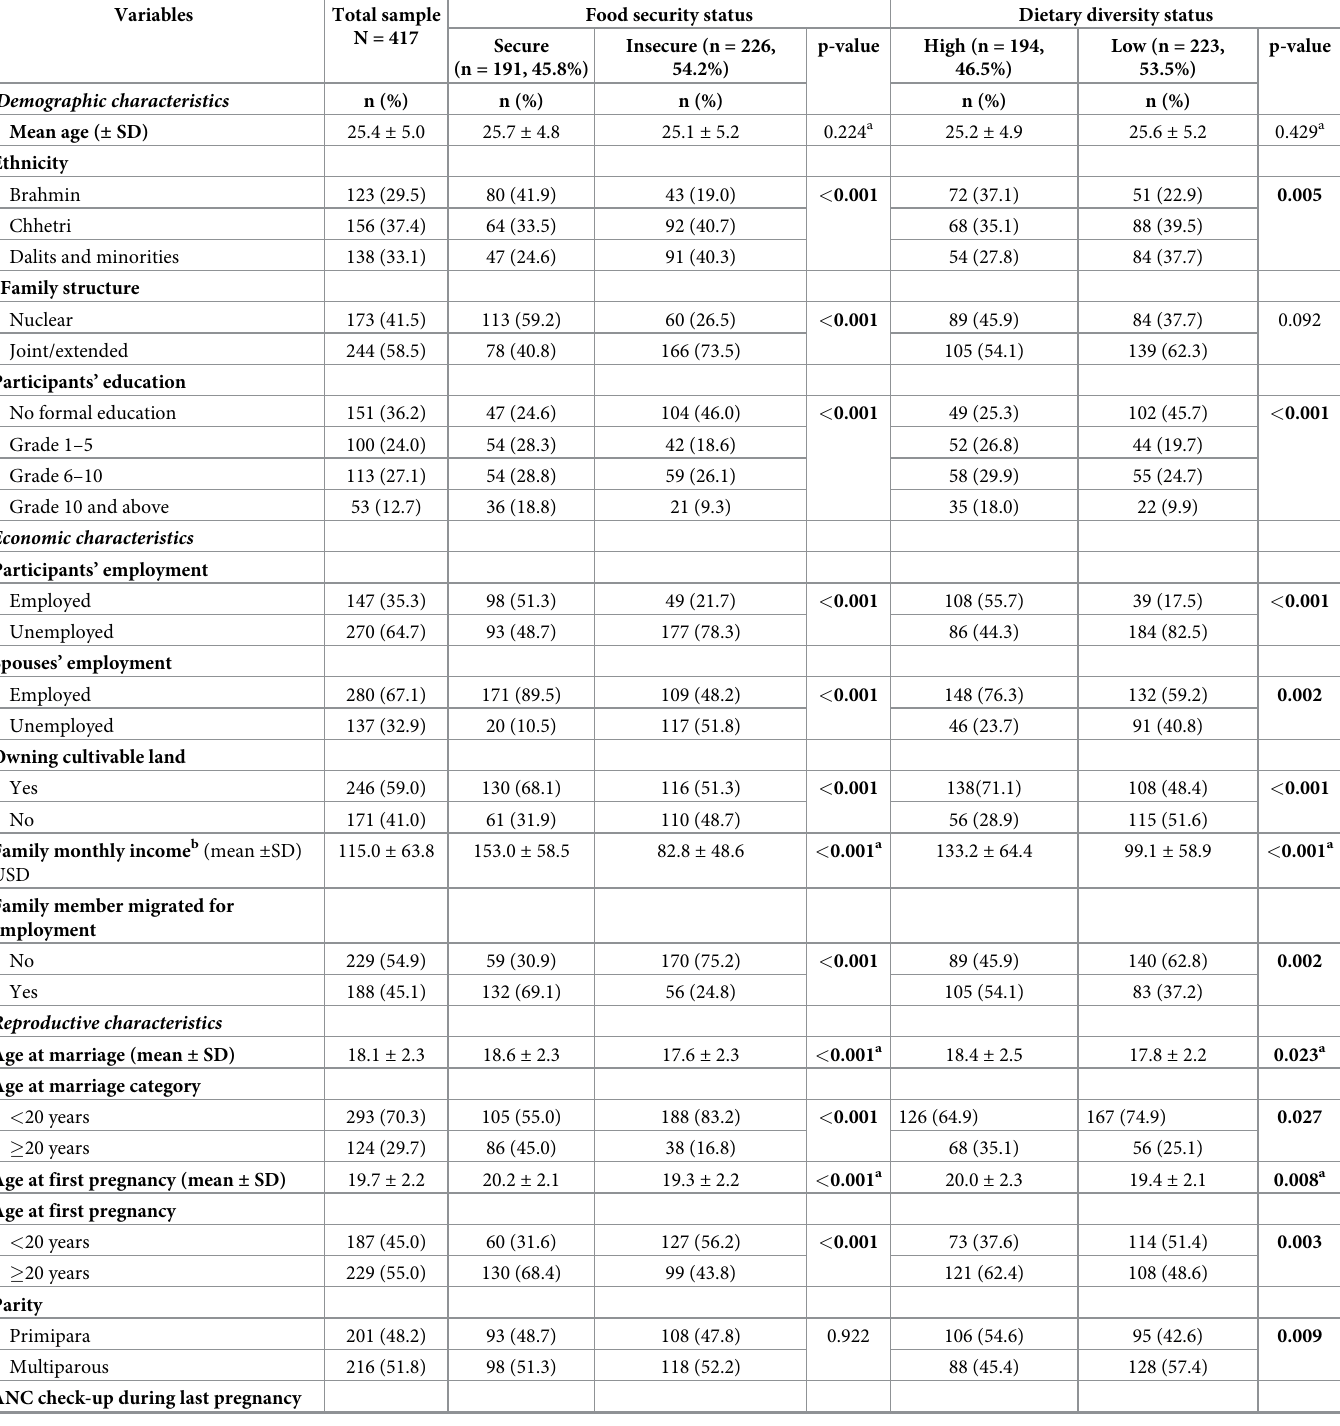
Table 1. Socio-demographic characteristics of lactating mothers by household food insecurity and dietary diversity status in Jaya Prithivi Municipality, Bajhang District, Nepal (n =